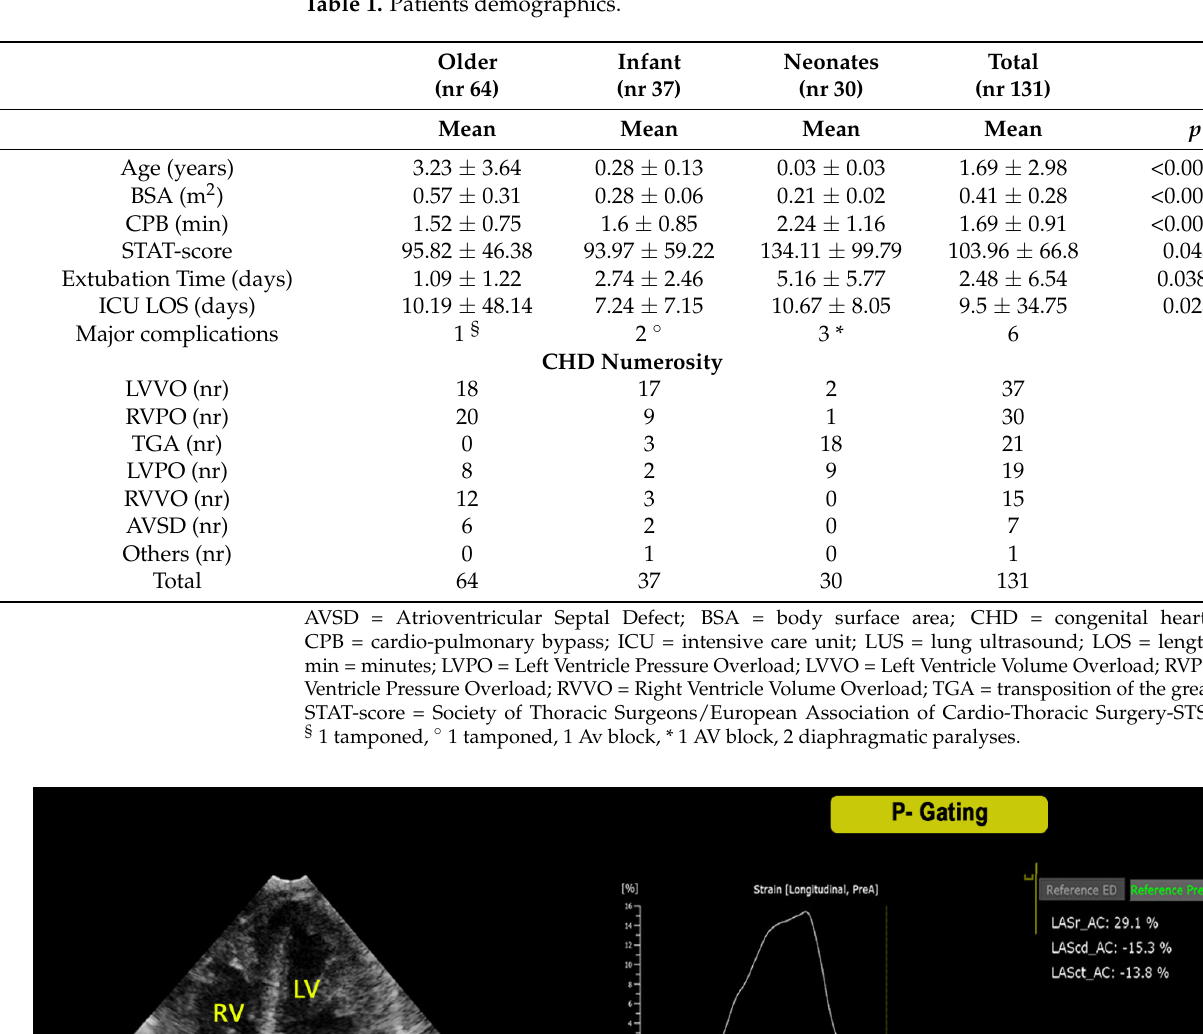
Table 1. Patients demographics.